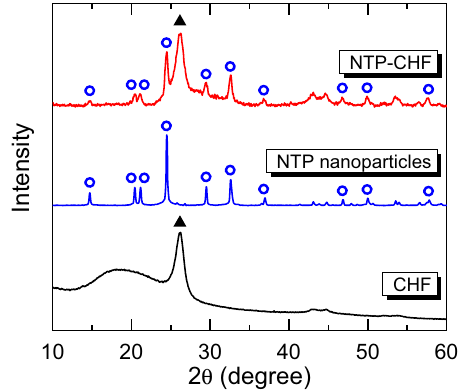
Fig. 2 XRD patterns of CHF, NTP nanoparticles, and NTP-CHF.